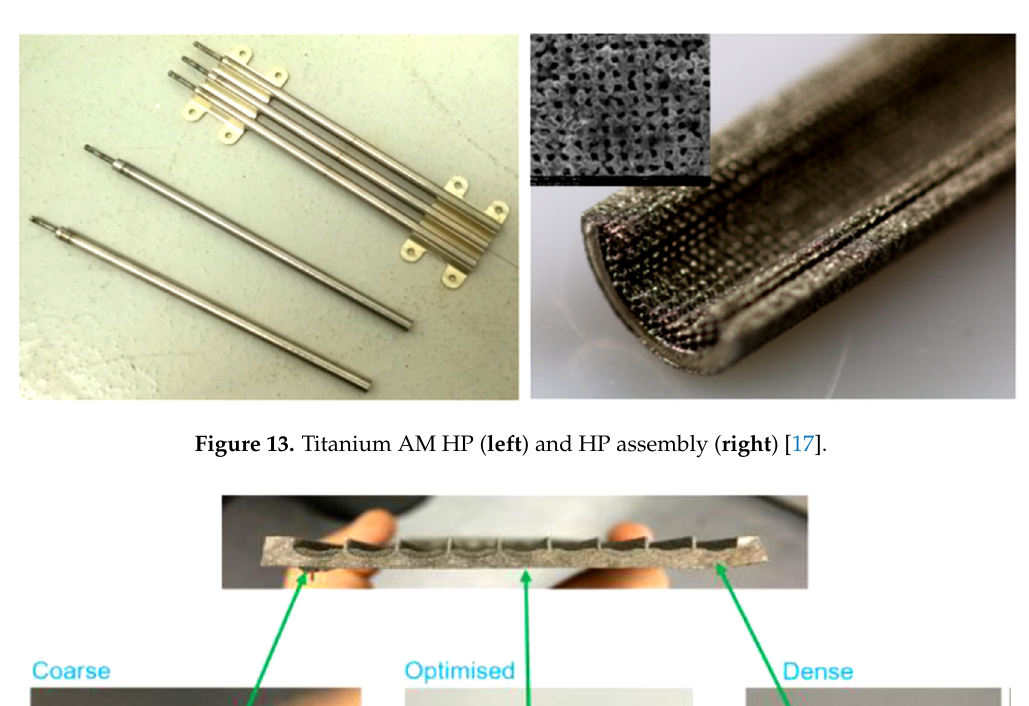
( c ) Figure 11. Schematic diagram ( a , b ) and photo of the evaporator ( c ) [39]. Figure 12. Photo of AM wicks [39]. The other advantage of using AM technology in HP manufacturing is the possibility of producing efficient gravity friendly wick structures that are capable of increasing the operating temperature range above that of ammonia (T max > 120 °C) and overcoming the challenges faced by traditional HPs, by expanding the functionality limits when operating